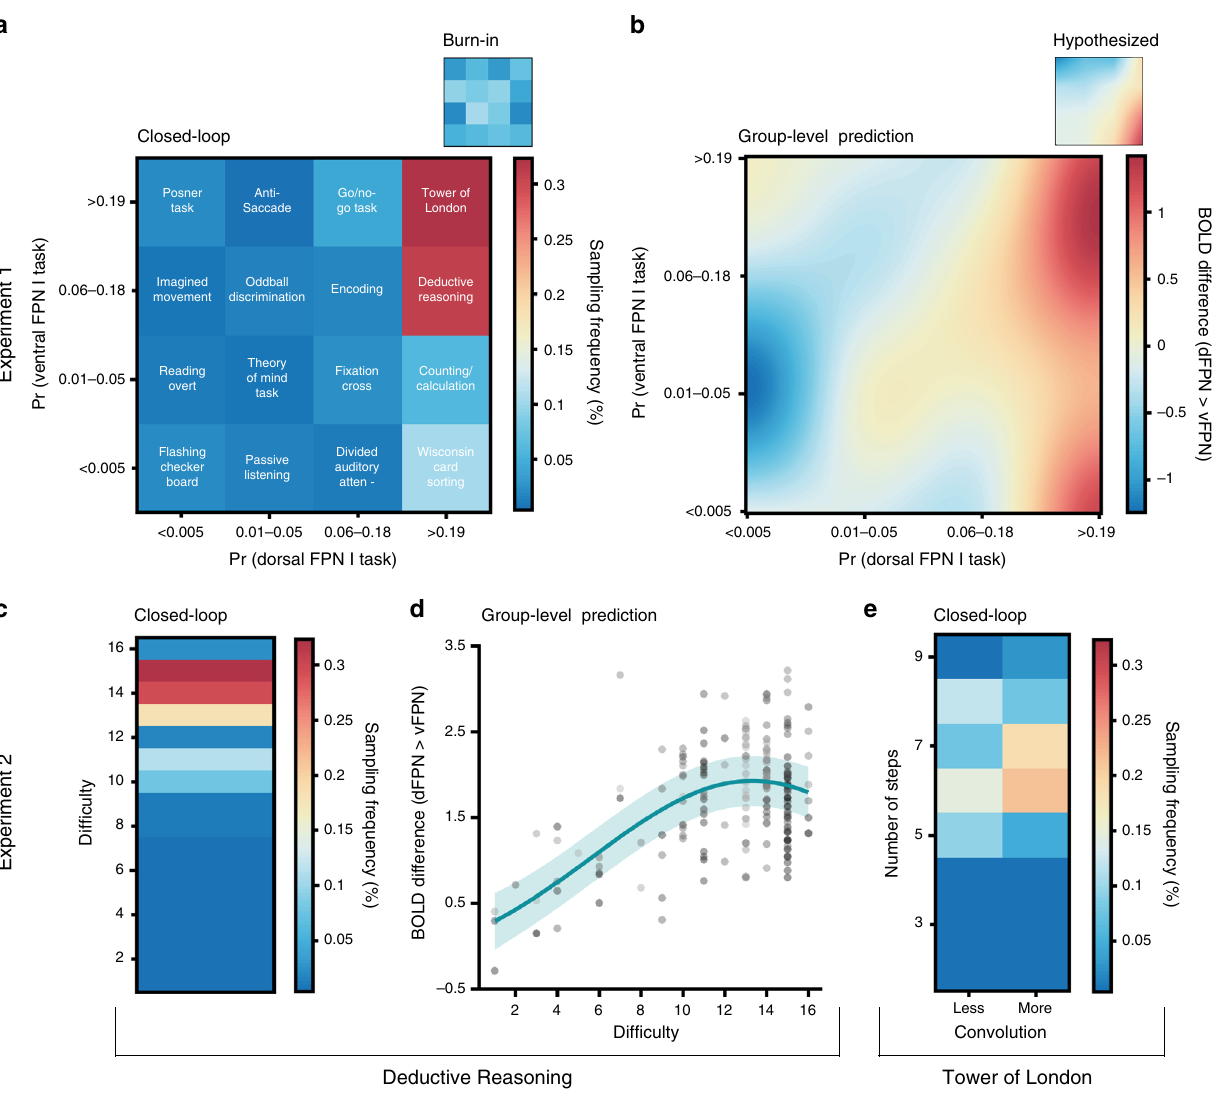
Fig. 2 Group-level results of Experiment 1 and Experiment 2. a Real-time sampling behavior of neuroadaptive Bayesian optimization and b group-level predictions across task space identify the Tower of London and Deductive Reasoning tasks to be optimal for dissociating the dFPN from the vFPN. c Real- time sampling behavior of optimization algorithm and d group-level predictions (observations colored by subject) show dif fi culty levels 13 – 15 to be optimal for the Deductive Reasoning task. e Real-time sampling behavior of optimization algorithm for the Tower of London task suggests 6 – 7 steps to be